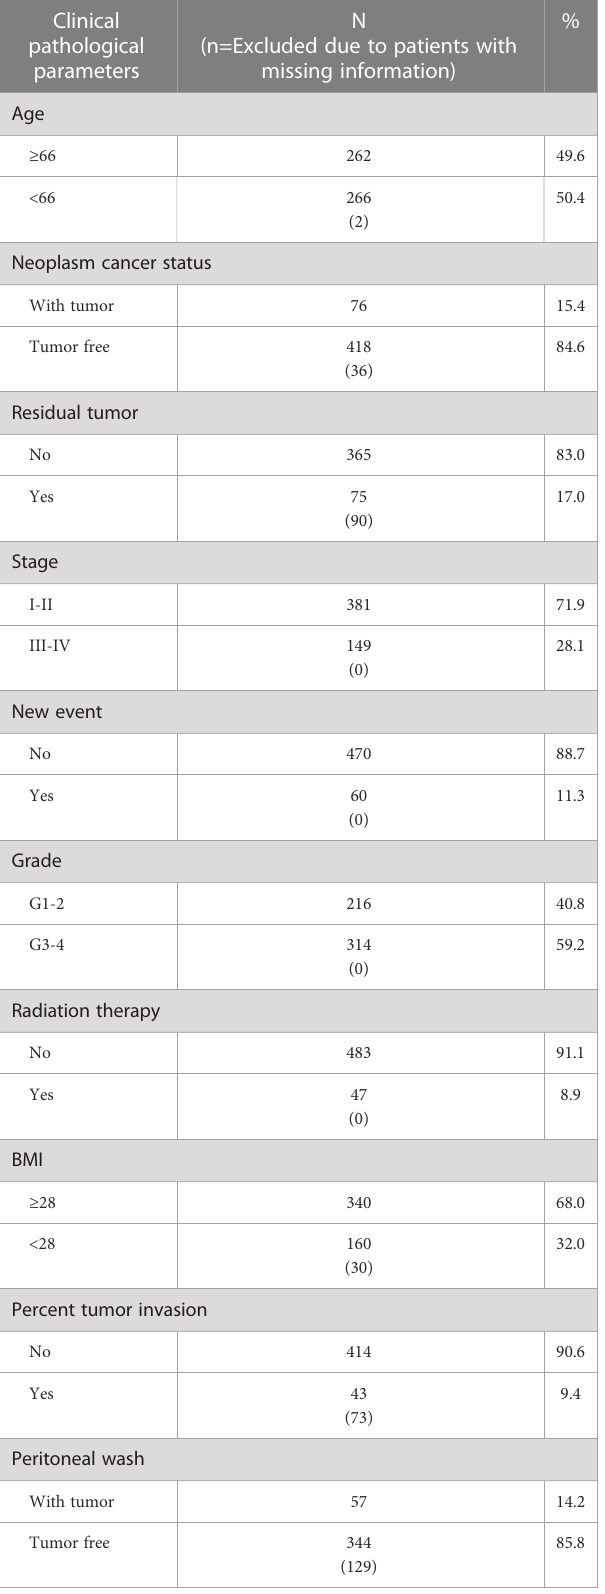
TABLE 1 Clinical pathological parameters of patients with Endometrioid cancer in this study.